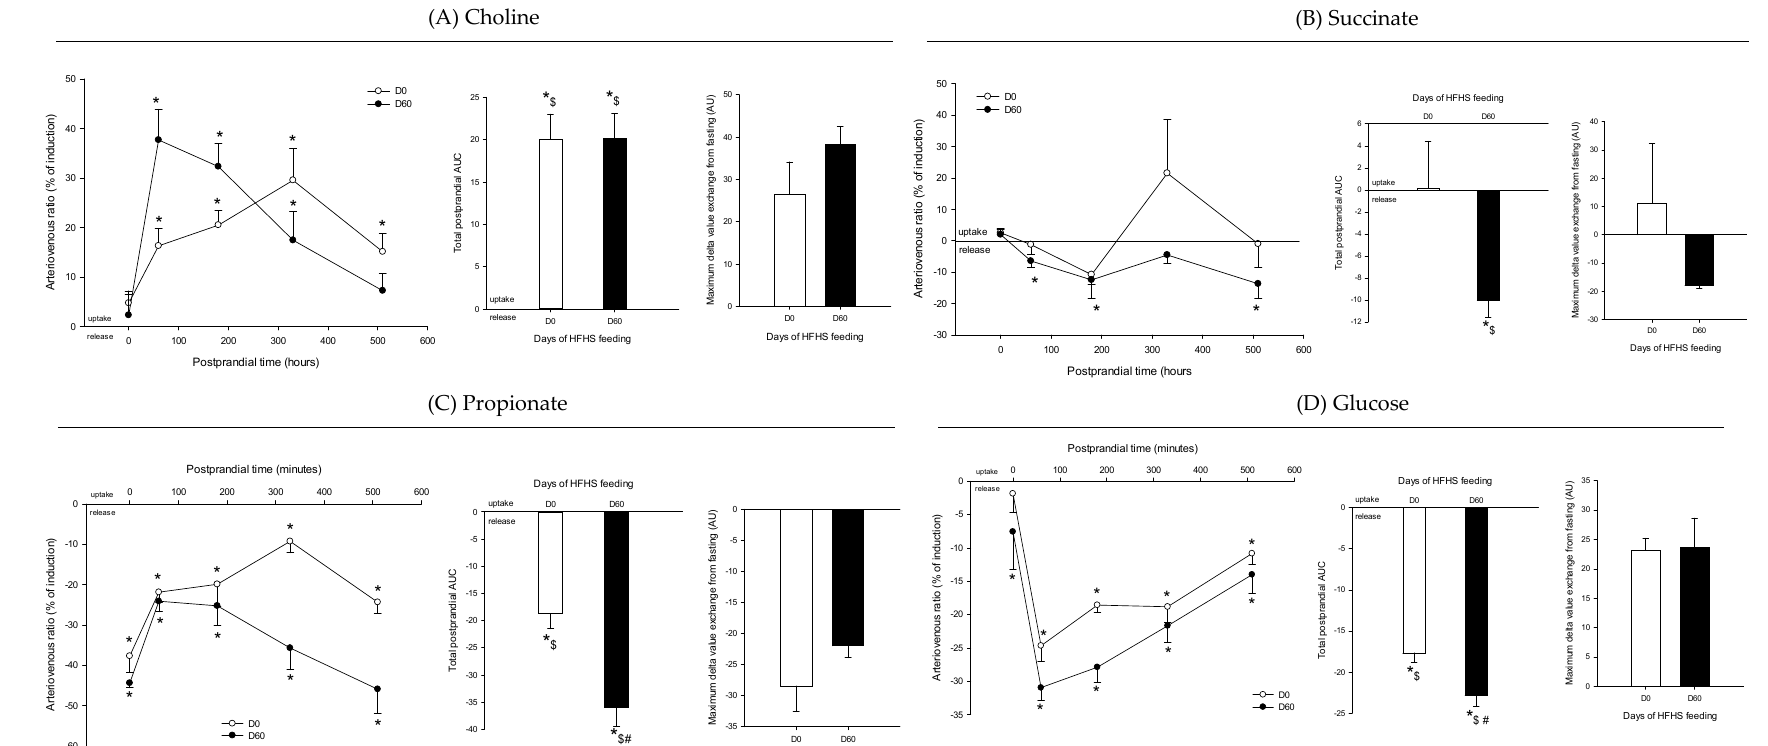
Figure 7. Arteriovenous fold-change (A/V) of ( A ) choline, ( B ) succinate, ( C ) propionate, and ( D ) glucose across the intestine on five Yucatan mini-pigs submitted to a HFHS diet during two months. Data is presented in % of induction (mean + sem) and the exchange was analyzed using a repeated-measures t -student test. *, significantly different from 0 (equilibrium), p < 0.05. For the A/V ratios and total postprandial AUC, positive values = taken up by the organ; negative values = released by the organ. #, significantly different from D0, p < 0.05; $, significantly different from the fasting condition, p < 0.05. The maximum delta value exchange from fasting is also presented: the positive and negative values represent an increase or decrease exchange following the meal, respectively.